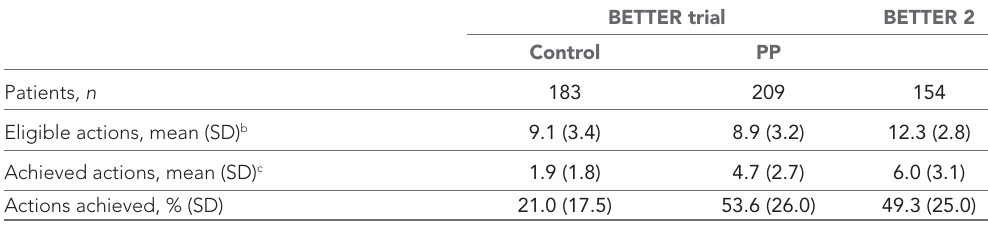
BETTER trial BETTER 2 Control PP